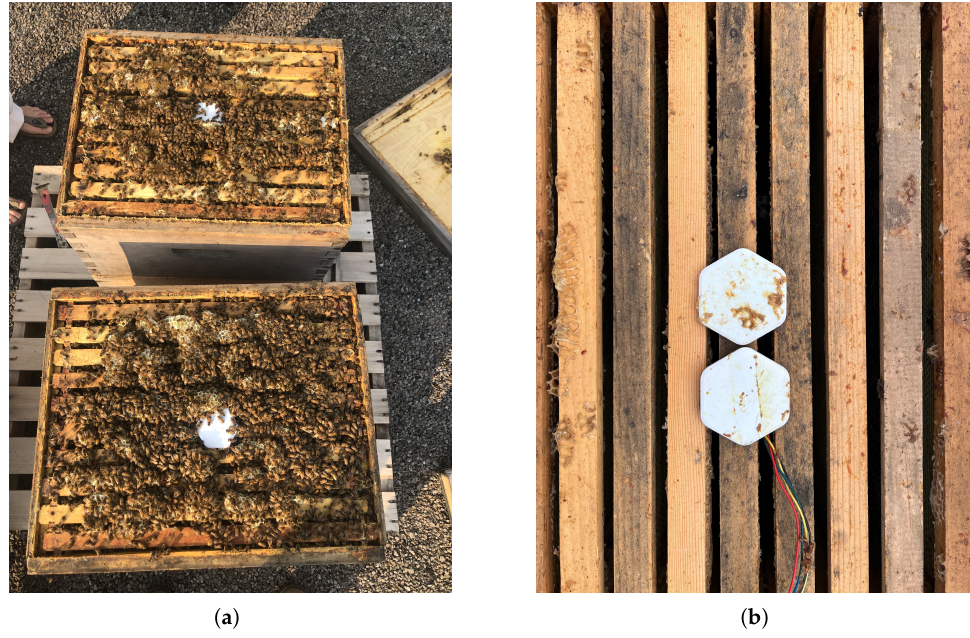
Figure 1. Location of the ( a ) temperature and humidity sensor placed on top of the middle frame of the first brood chamber and ( b ) microphone placed next to